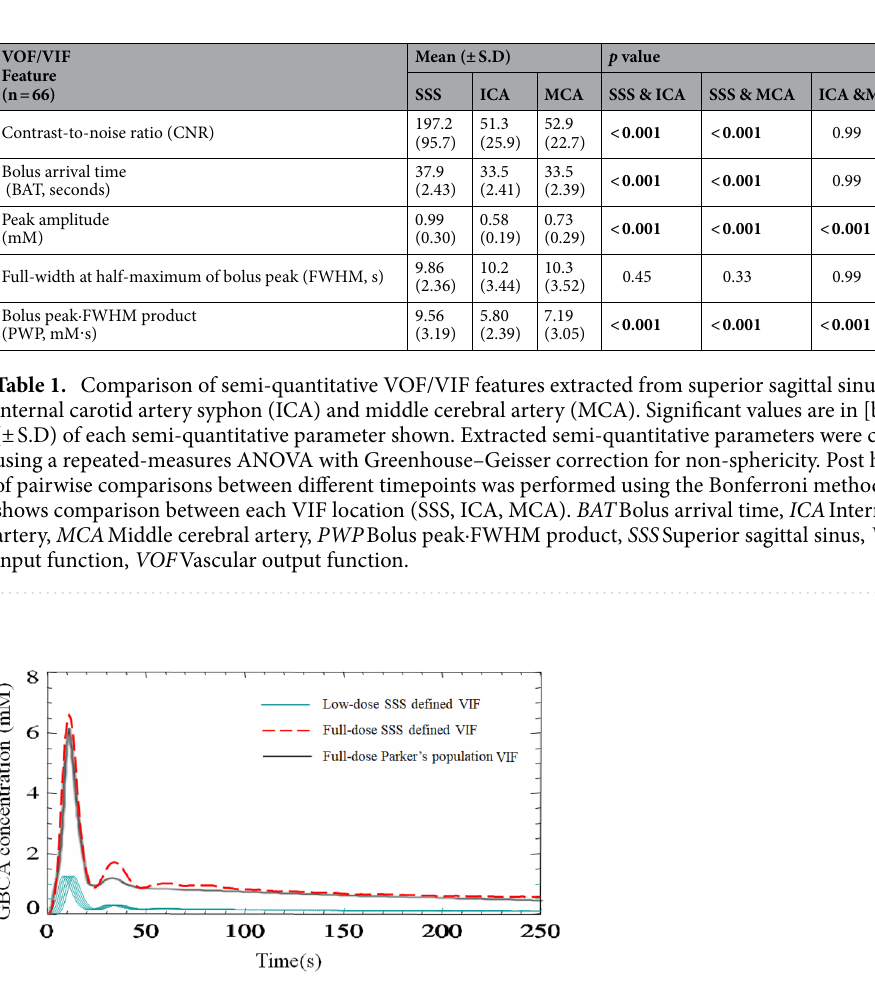
Figure 3. Comparison between an individual patient derived vascular output function from the SSS (VOF SSS ) and the population VIF measured in the descending aorta by Parker et al. VOF extracted from the vertical segment of the superior sagittal sinus (SSS) in the same patient as shown in Fig. 2. Six low-dose (0.016 mmol/kg of GBCA) VIFs ( blue solid curves ) derived from the SSS were time-shifted and summed to generate a full-dose (0.1 mmol/kg) input function ( red dashed curve) . The shape and amplitude of this summed SSS derived VIF shows high similarity with Parker’s full-dose VIF ( black solid curve ), in keeping with the observed lack of bolus widening (bolus FWHM) between the large arteries and the